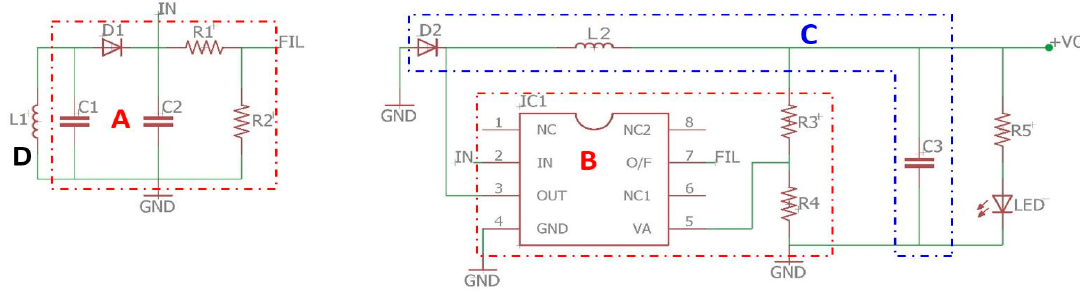
Figure 13. The wireless power receiver apparatus core. Part A is a voltage rectifier and input filter, part B is a voltage regulator, part C is an output filter and protection, and part D is receiver coil.